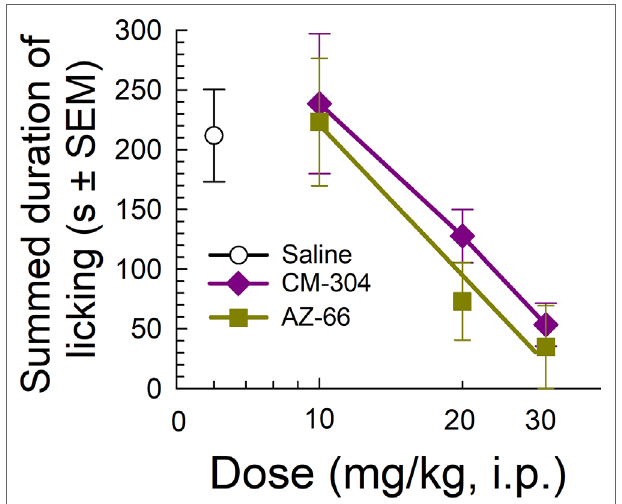
FIGURE 6 | Dose-dependent antinociception of sigma-receptor antagonists CM-304 and AZ-66 following i.p. administration in the mouse formalin assay. Control mice treated with saline (0.9%, i.p.; n = 8). All points represent average response ± SEM administered to 8–10 mice.